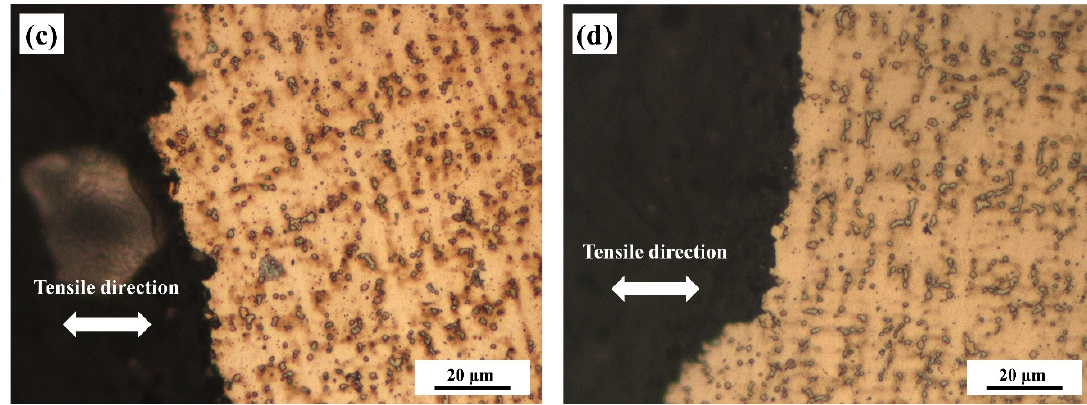
Figure 12. The cross-sectional microstructure near the fractured surface of the repaired Inconel 718 alloy specimen with pre-hot corrosion for different exposure times: ( a ) 0 h, ( b ) 50 h, ( c ) 100 h, and ( d ) 150 h